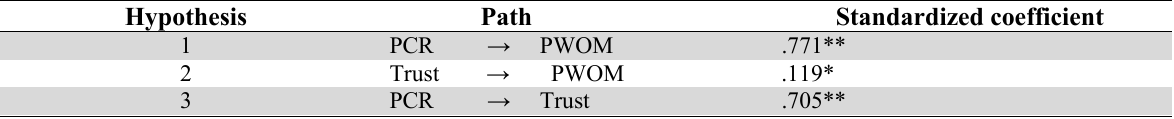
Path analysis Hypothesis Path Standardized coefficient 1 PCR → PWOM .771** 2 Trust → PWOM .119* 3 PCR → Trust .705** **p<.001; *p<.05